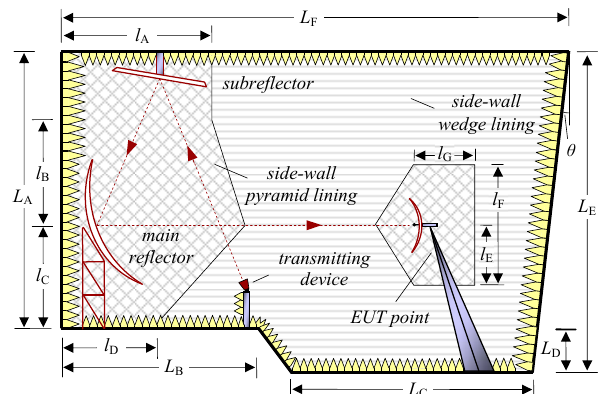
Figure 16: Geometry of an inclined-wall dual reflector com- pact range anechoic chamber. Modeling regions: complex- interface schemes for the antennas and the absorbers, opti- mized FVTD technique for the reflectors and the walls, and PSTD algorithm for the interior of the facility.